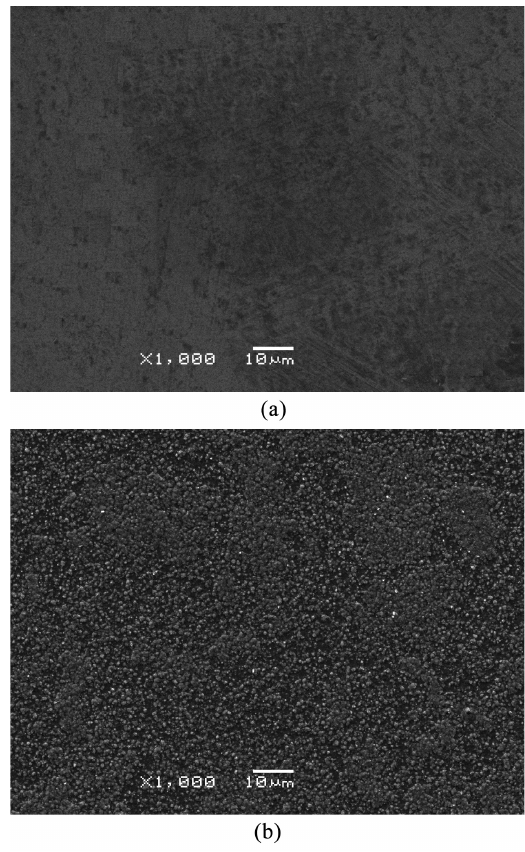
Figure 1. SEM micrograph of the surface aspect of: (a) non-nitrided; and (b) nitrided